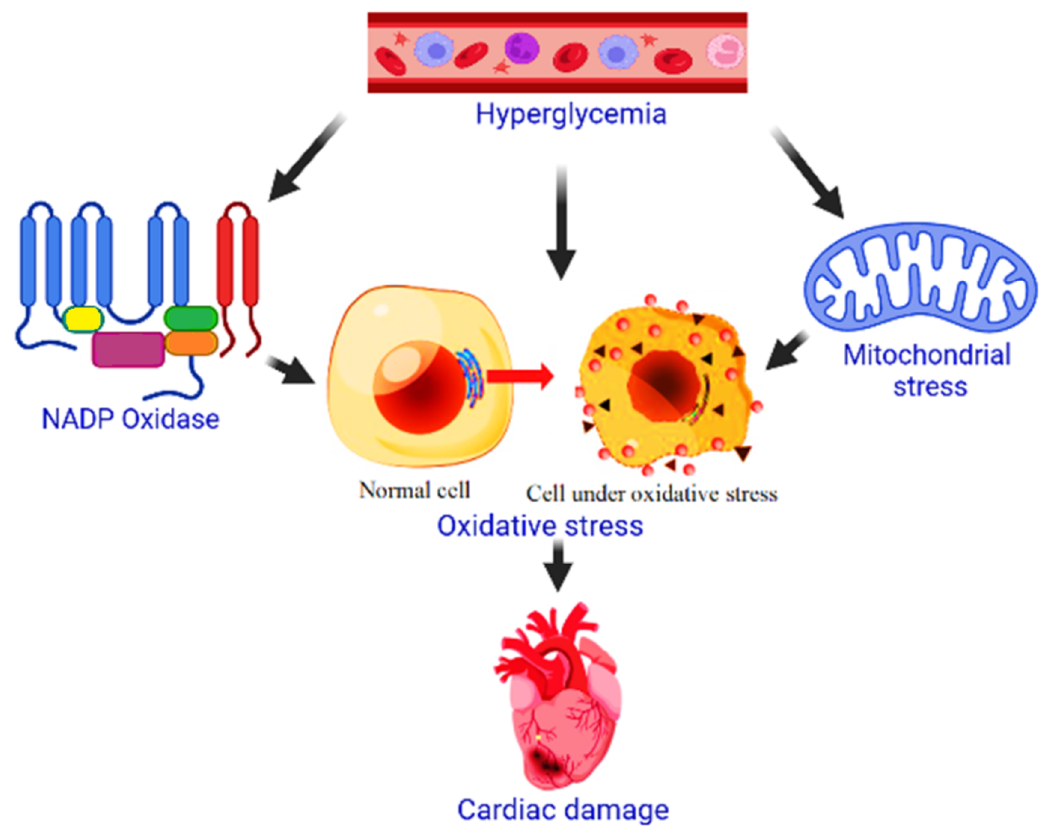
Figure 2. Role of NADPH oxidase and mitochondrial stress on cardiac injury due to